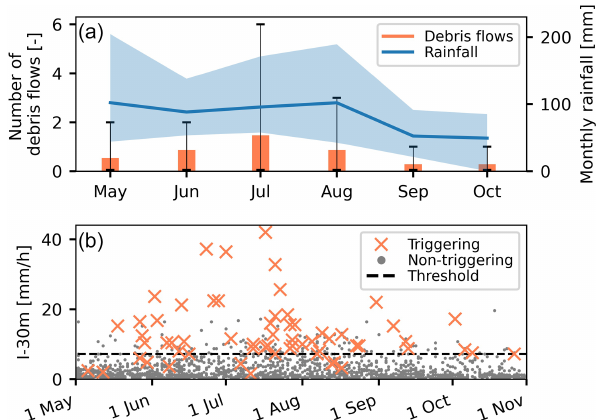
Figure 3. (a) Mean number of debris flows per month (orange bars) and mean monthly rainfall (blue line) in the Illgraben catchment. The thin error bars (black) and the shaded area (blue) show the inter-annual variability, i.e. the observed minimum and maximum in each month between 2001 and 2017. (b) Peak 30min rainfall in- tensity in debris-flow-triggering and non-triggering rainfall events. The threshold (7.2mmh − 1 ) was determined by optimizing the TSS